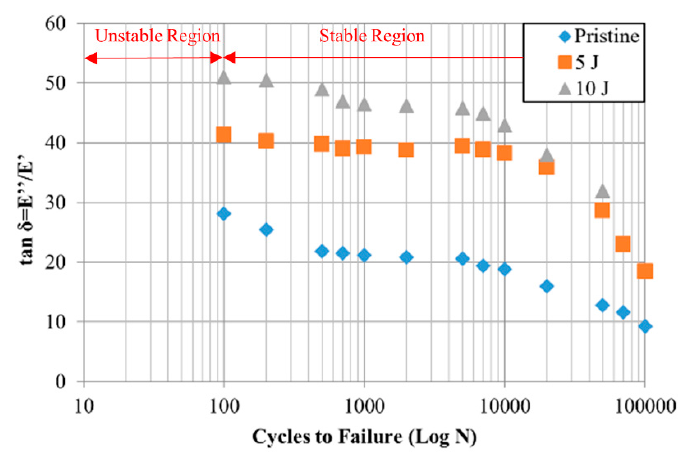
Figure 13. Tan ( δ ) vs. Log (N) graph for the 9AL10b specimen.